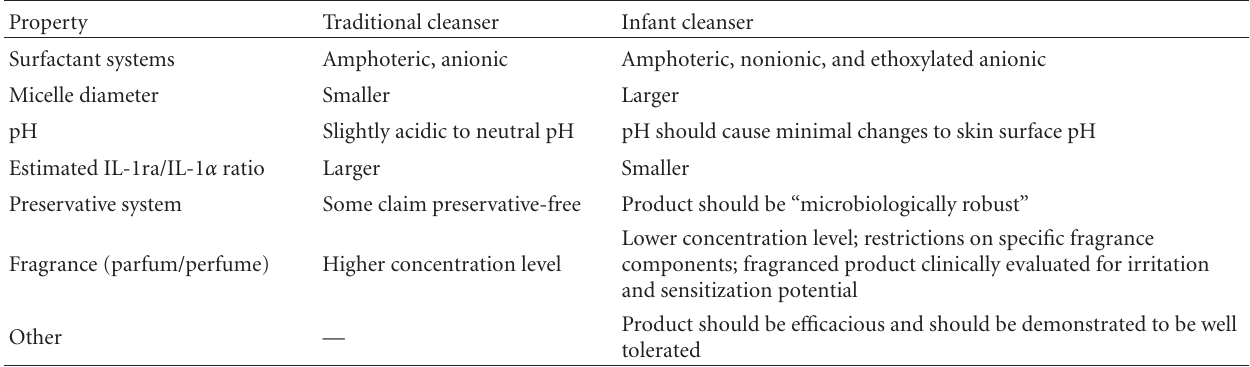
Table 2: Ideal properties of appropriately formulated cleansers for neonates and infants.